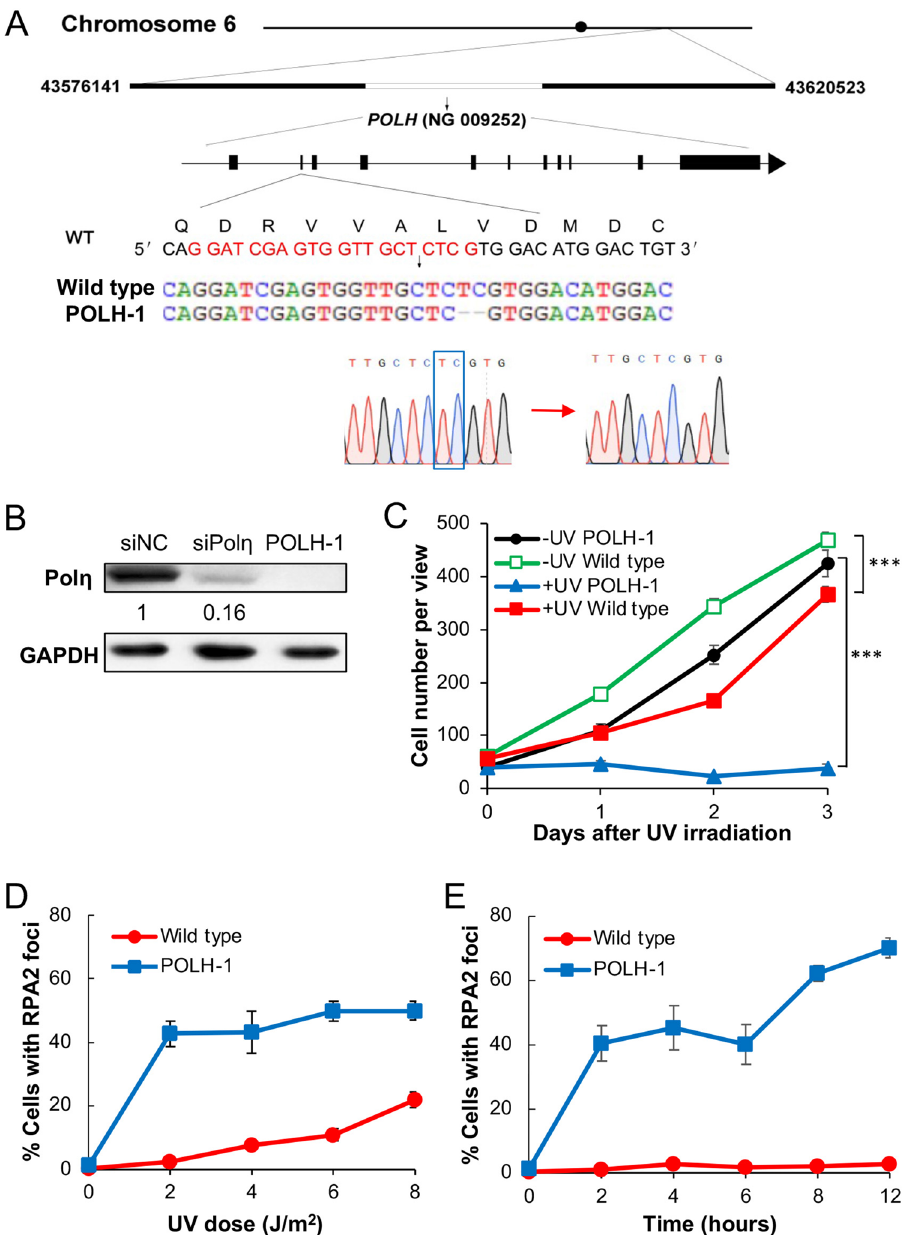
Figure 4. Creation and characterization of an POLH-1 cell line. ( A ) The POLH gene location, genomic structure and mutation in the POLH-1 cell line. Nucleotide and encoded amino acid sequences around the guide RNA target (in red) are shown. DNA sequence confirmation of the 2-nt deletion (blue box) in the POLH-1 cells is also illustrated. ( B ) Western blot analysis of Polη in 293T, siPolη-treated and POLH-1 cells. For siPolη depletion, 293T cells were transfected with siPolη molecules and harvested 48 h after treatment. The number indicates the band intensity relative to non-specific siRNA (siNC) treated cells. ( C ) Relative cell growth with or without UV irradiation. 293T and POLH-1 cells were cultured for 2 days followed by 5 J/m 2 UV irradiation and counting viable cells over time. ( D ) RPA2 focus formation in 293T and POLH-1 cells 4 h after exposure with different UV doses. ( E ) RPA2 focus formation in 293T and POLH-1 cells after 2 J/m 2 UV irradiation over time. ( C - E ) Data are means of three independent experiments ± SEM. ***, P < 0.001 by two- sided Student’s t